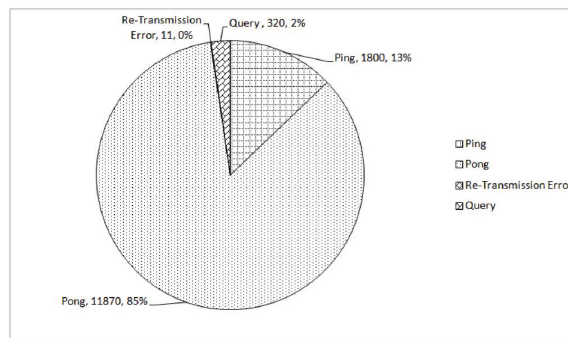
Fig. 9. Division of packets for Gnutella